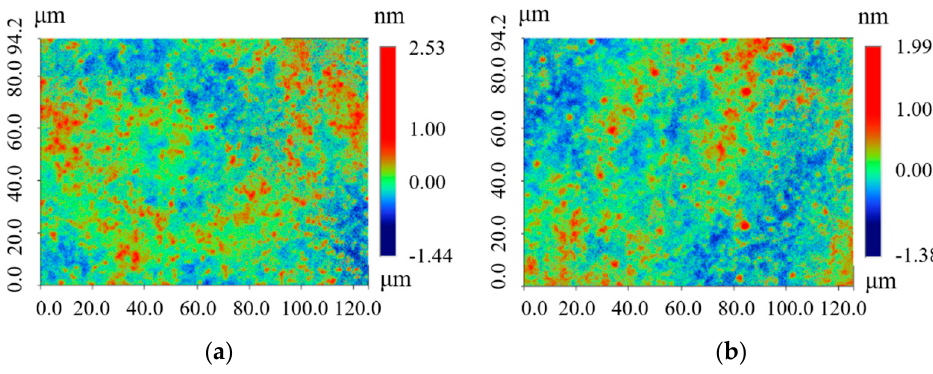
Figure 16. Surface roughness: ( a ) before coating, ( b ) after coating.